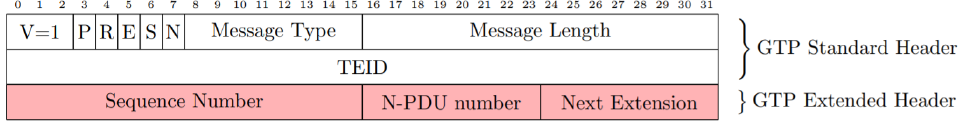
Figure 6. GTP-U header with extensions. Source: [19].